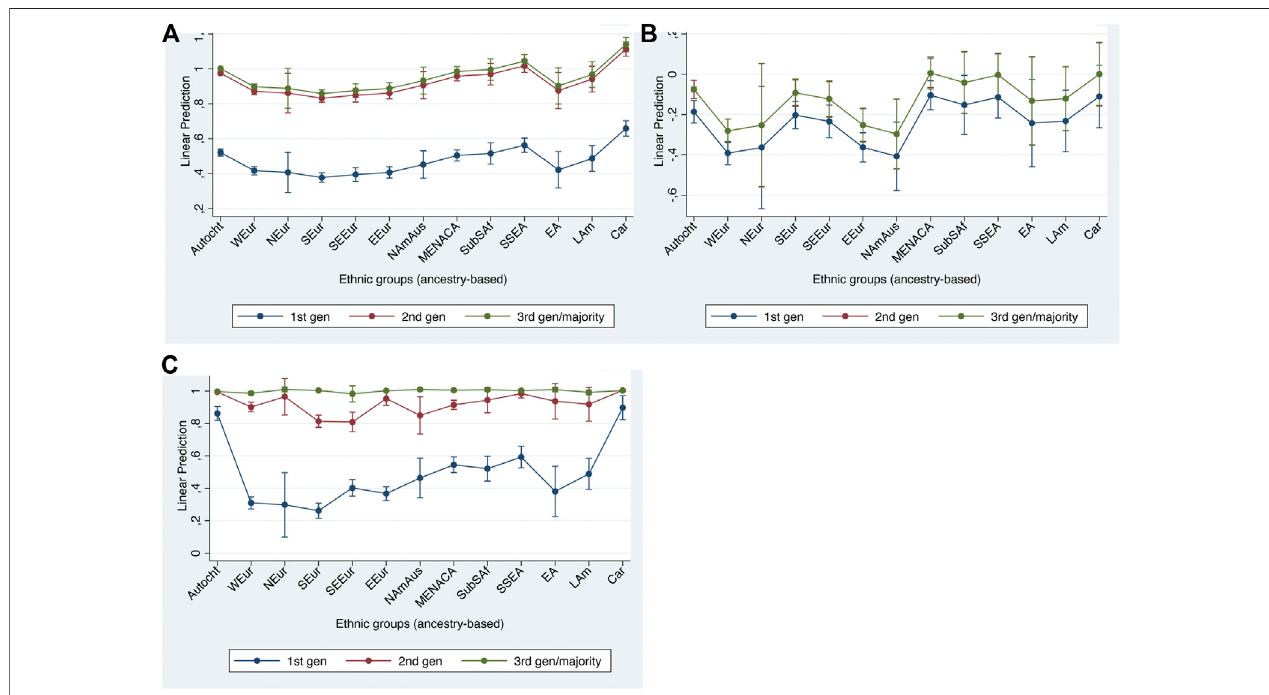
FIGURE 5 | Adjusted predictions at representative values for civic integration indicators with 95% con fi dence intervals. (A) citizenship (main effects model); (B) national attachment (main effects model); (C) citizenship (interaction effects model).